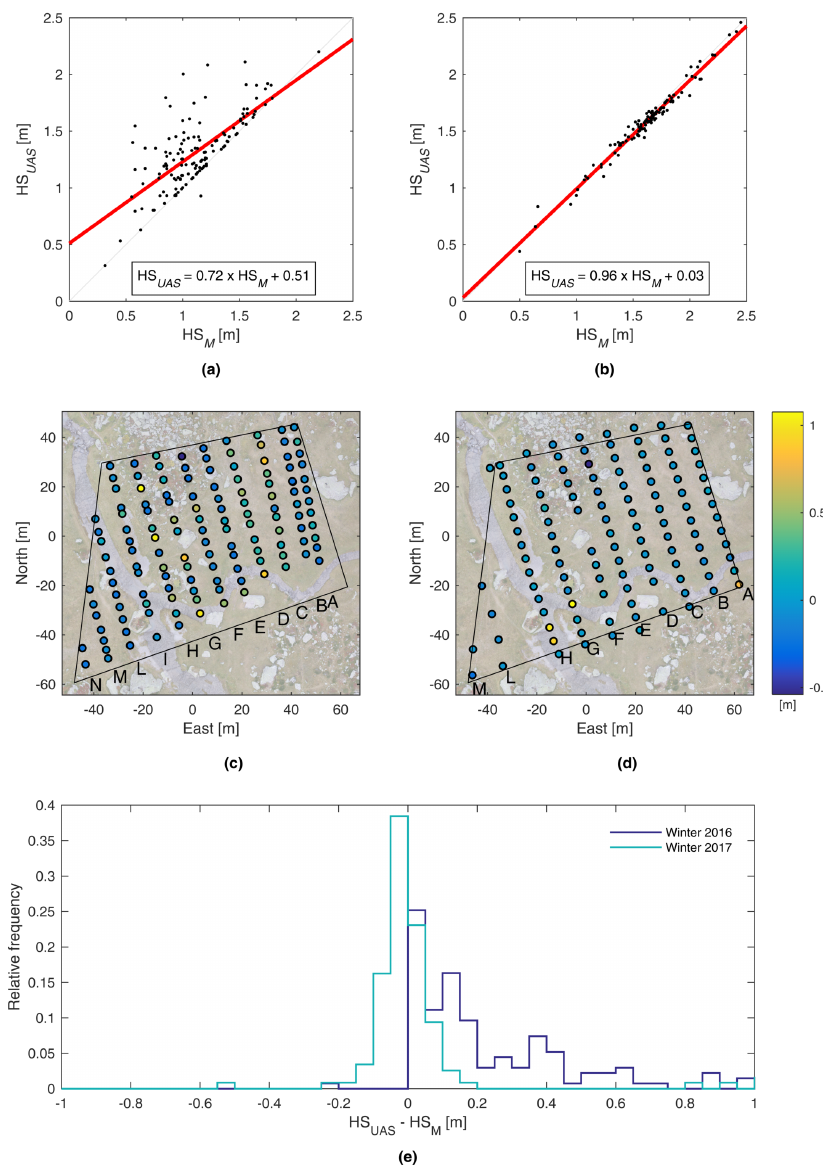
Figure 5. Evaluation of UAS data using manual probing. ( a , b ): Scatter plots between UAS-based and manual measurements of HS for 2016 and 2017, respectively (regression line in red). ( c , d ): Spatial distribution of the differences between UAS-based and manual measurements of snow depth. The color legend represents the differences between UAS and manual probing. ( e ): Histograms of the differences between UAS-based and manual measurements of snow depth for both